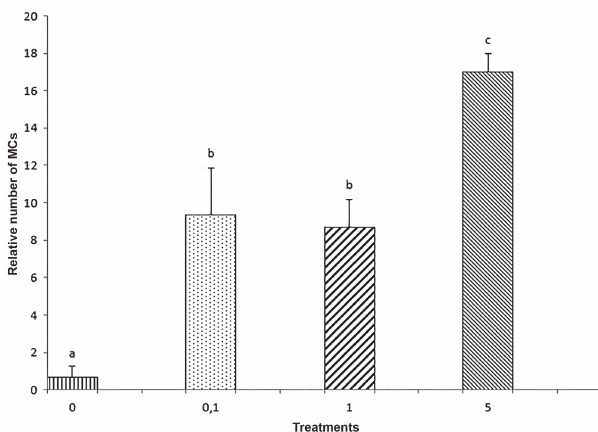
Fig. 4. Number of AP and PDR parenchyma MC cells found for each one of Roundup Activo™ treatments. Each value represents mean ± SD. Different letters correspond to significant differences (P<0.05 values). The treatments are in units of mg / L. N= 3.